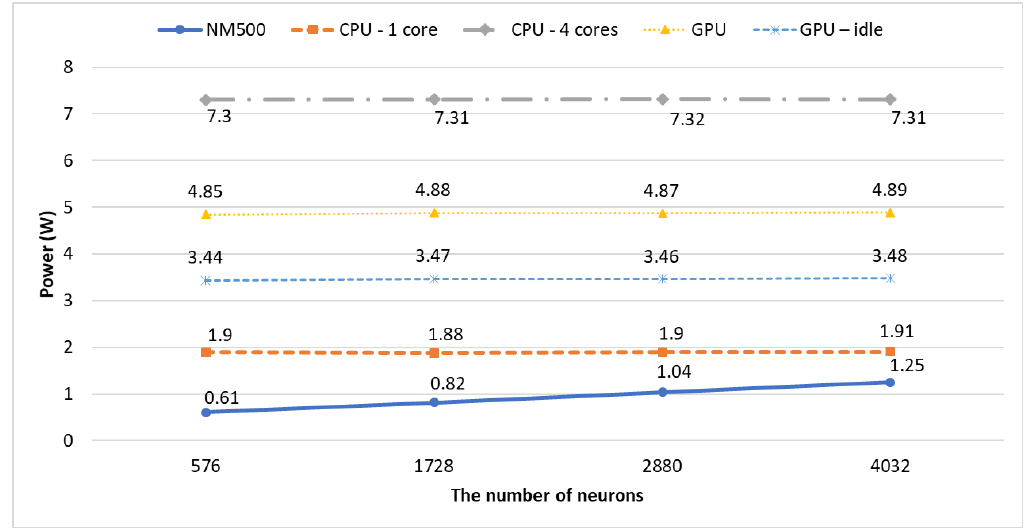
Figure 2. Average power consumption for varying numbers of neurons.